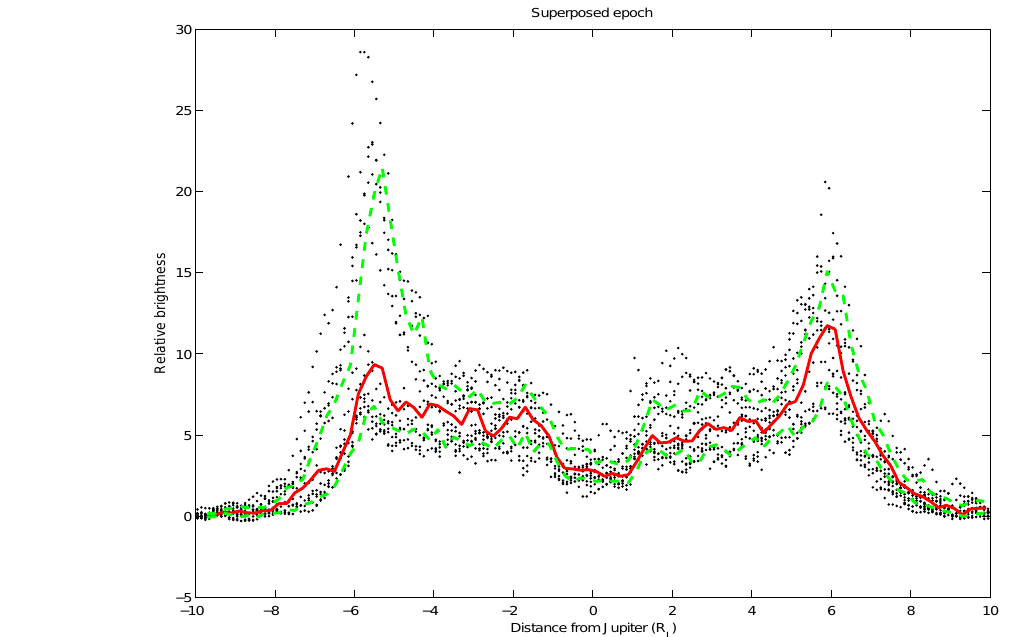
Figure 1. The UVS scan 7101 from 12 March 1979 showing the relative brightness as a function of radial distance from Jupiter. The full scan runs over − 10 R J ≤ R ≤ 10 R J with a resolution of 0.1 R J . Clearly visible are the bright ansae near R ≈ ± 6 R J